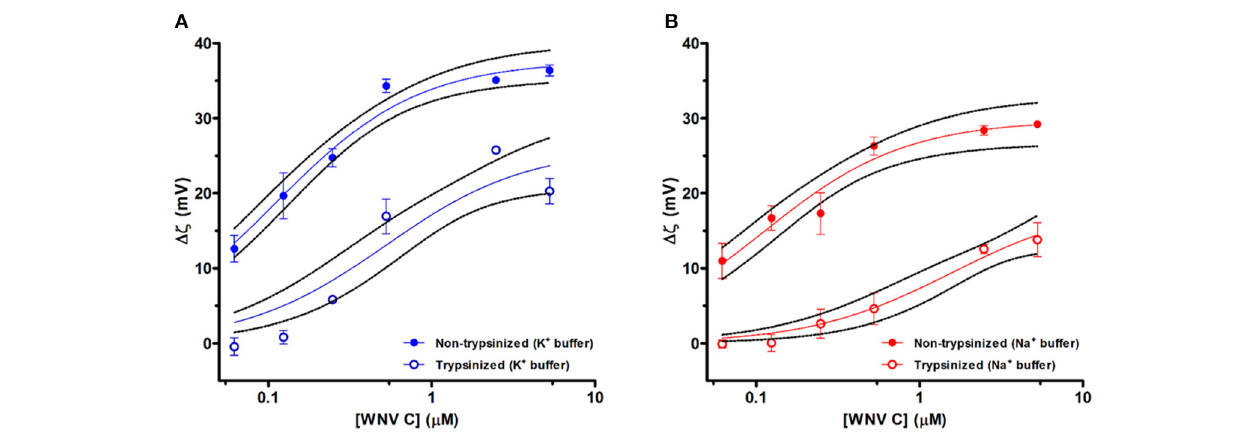
FIGURE 1 | LDs ζ -potential analysis at different WNV C concentrations. Variation of ζ -potential ( 1 ζ ) values of LDs samples isolated with TEE KCl buffer (K + buffer) (A) and TEE NaCl buffer (Na + buffer) (B) in the absence and in the presence of distinct WNV C concentrations. ζ -potential values determined for LDs without trypsin preincubation (filled symbols) and LDs pre-incubated with trypsin (empty symbols). WNV C concentration axes are presented in logarithmic scale. Results are presented as mean ± standard error (SE). Experiments were performed in triplicate. Solid lines were obtained by fitting the experimental data using Equation 3. WNV C binds to LDs inducing a progressive increase in the surface charge of the LD-WNV C complex.